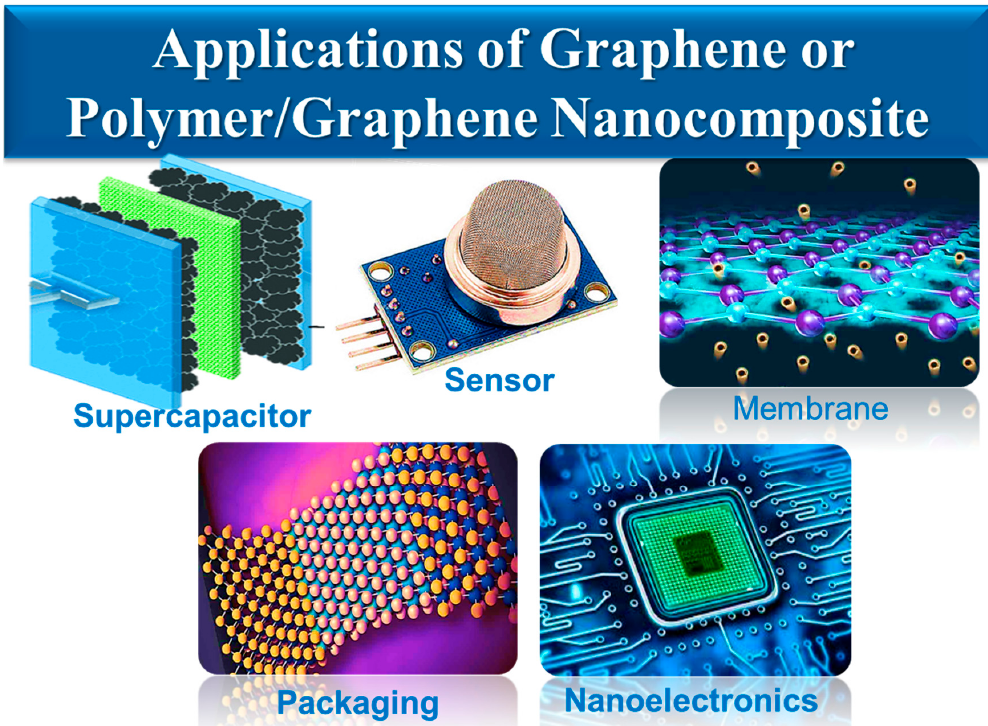
Figure 3. Applications of polymer–graphene